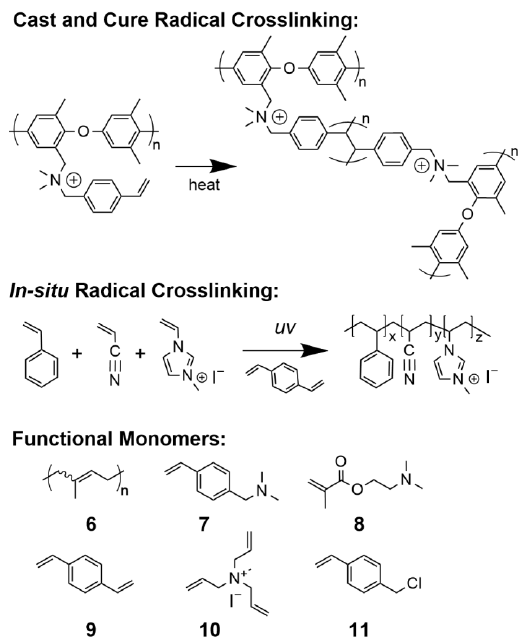
Figure 11. Free radical polymerization strategies for the fabrication of crosslinked AAEMs. Polymers 2023 , 15 , x FOR PEER REVIEW